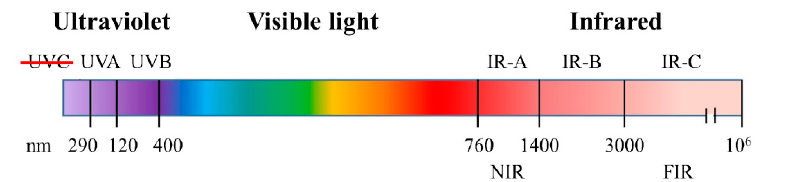
Figure 3. Solar spectrum composition. Red bar over UVC means that the ozone layer blocks them (NIR: near infrared, FIR: far infrared).